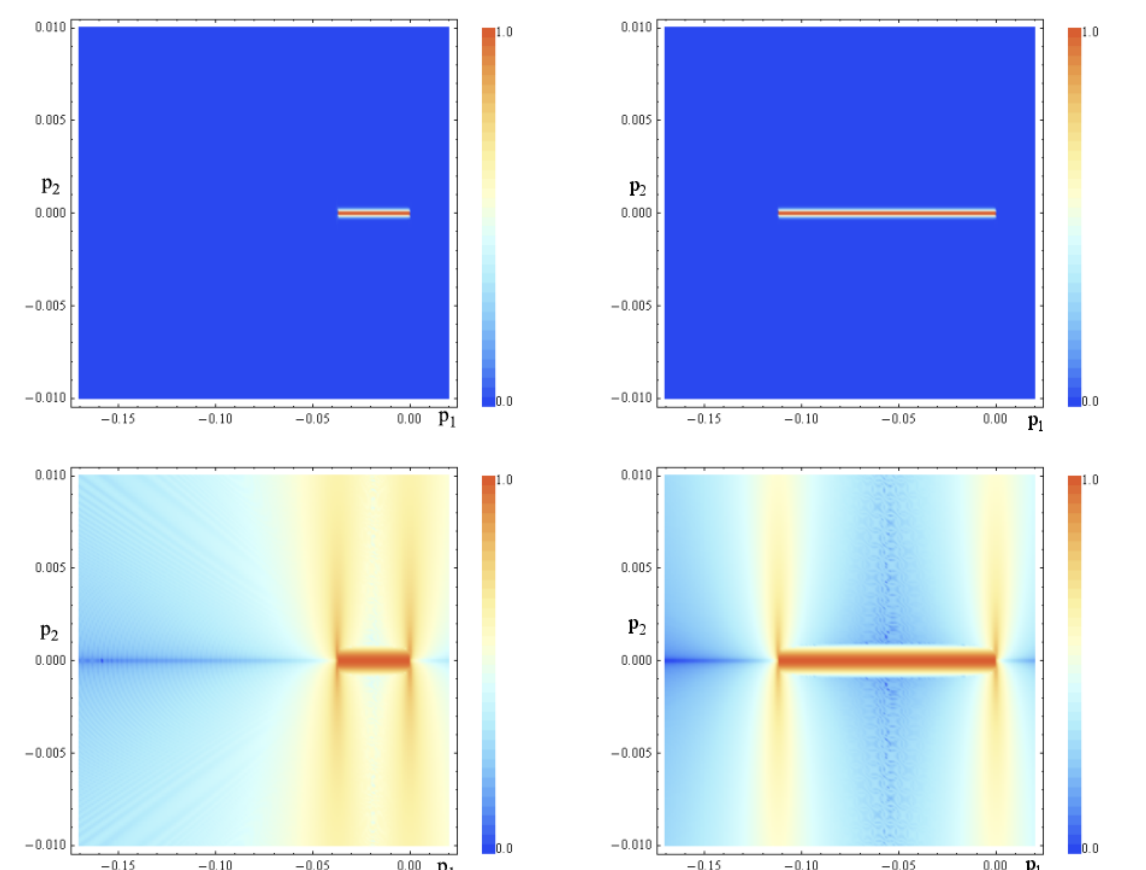
Figure 8. The residual distribution function in momentum space after the action of the field of type (57) with E a = 10 V/cm for a duration of 1.0 × 10 − 10 s ( left column ) and 3.0 × 10 − 10 s ( right column ). A logarithmic color scale used for the bottom